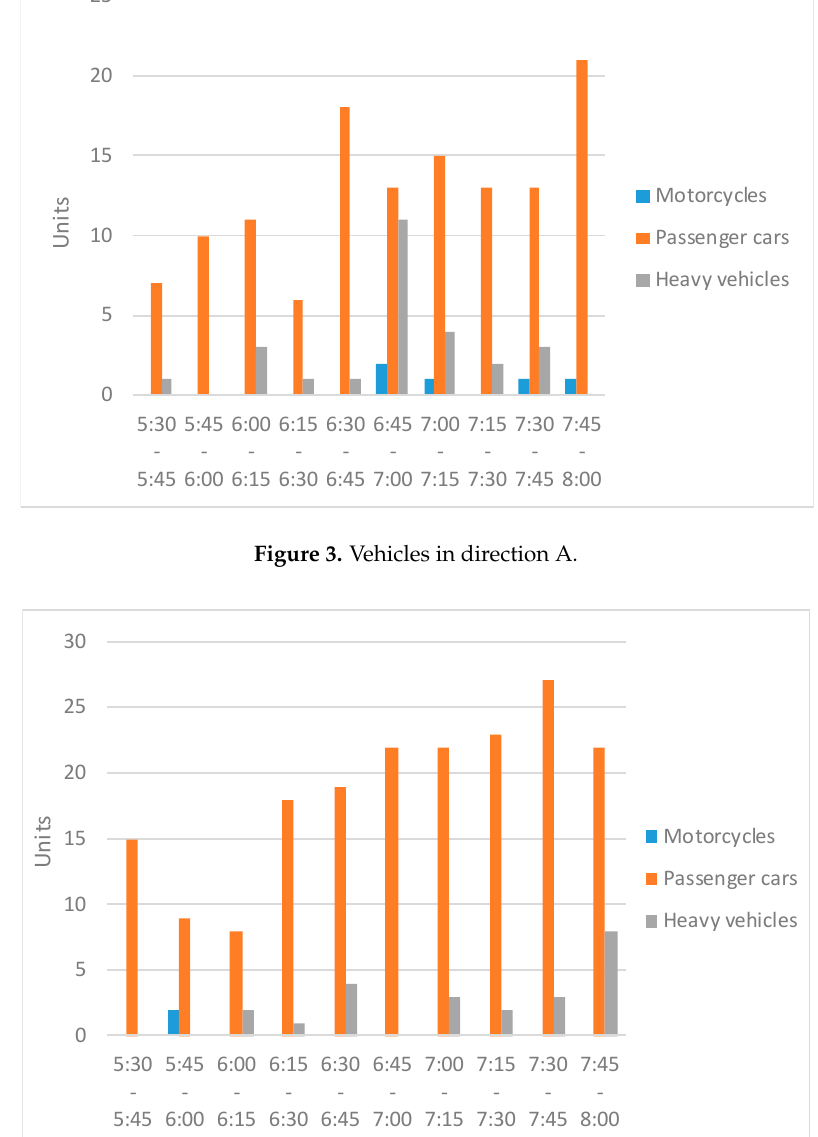
Figure 4. Vehicles in direction B.